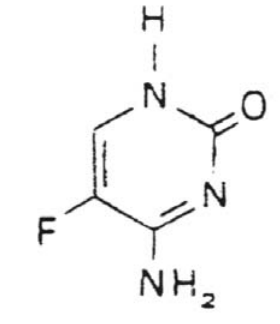
FIGURE 8. Chemical structure of